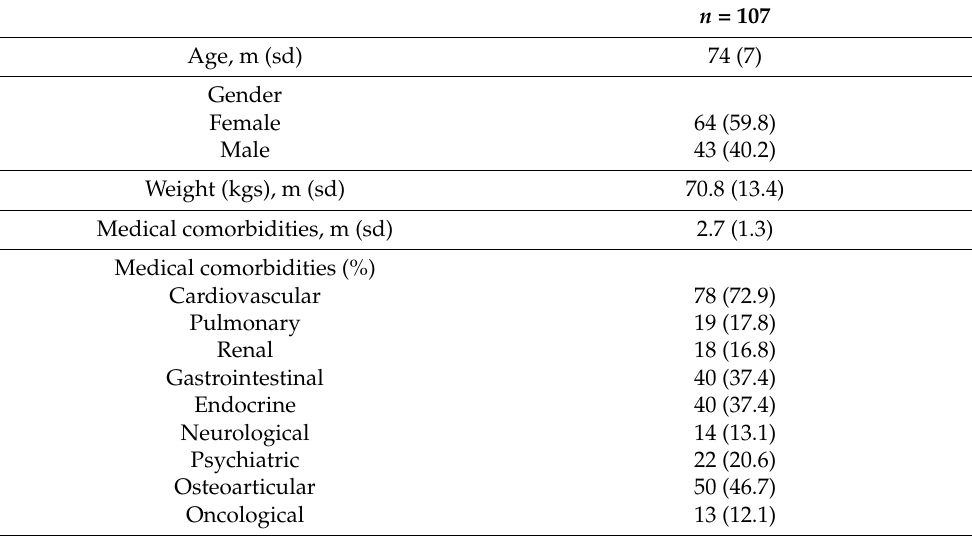
Table 2. Population